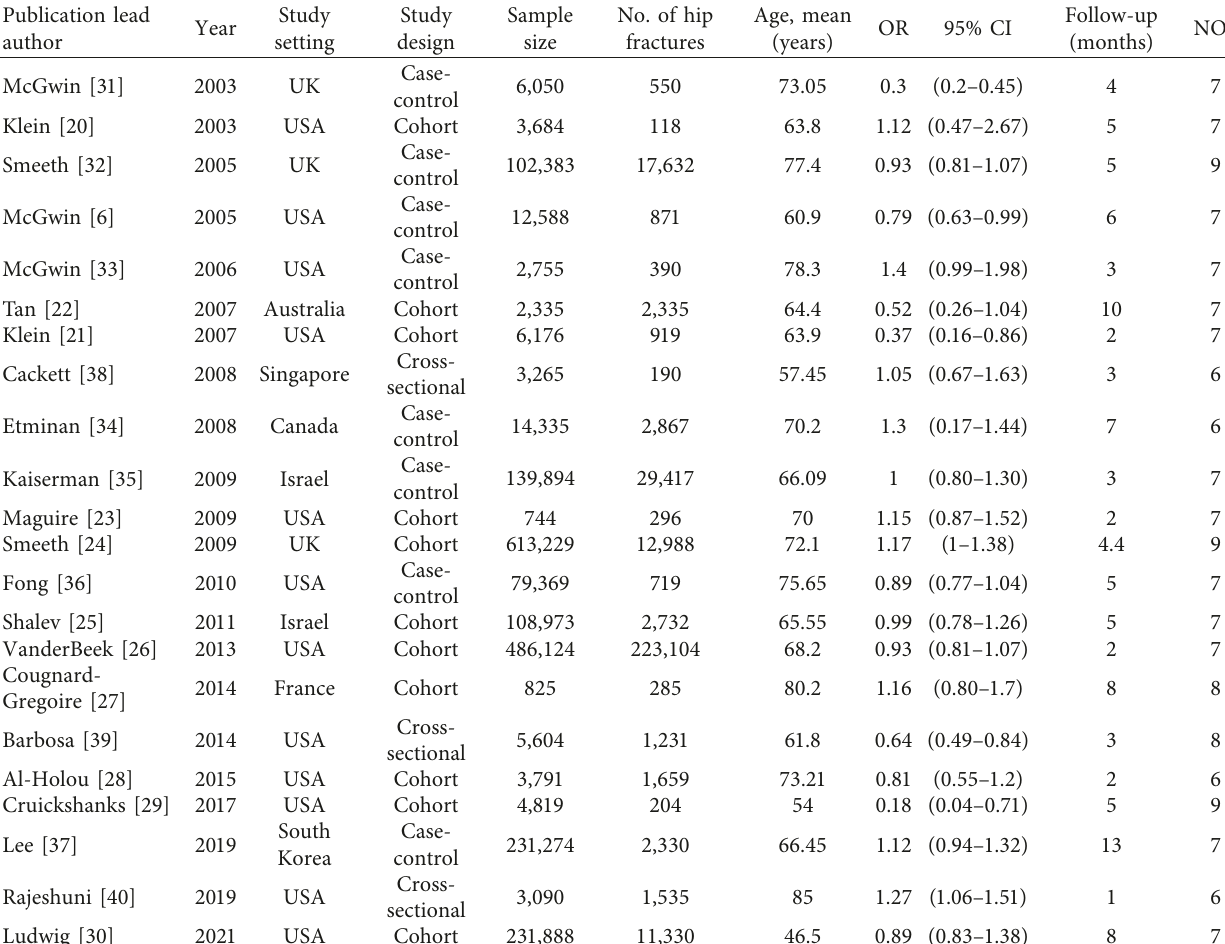
Table 1: Characteristics of studies reviewed for the relationship between statin consumption and risk of developing age-related macular